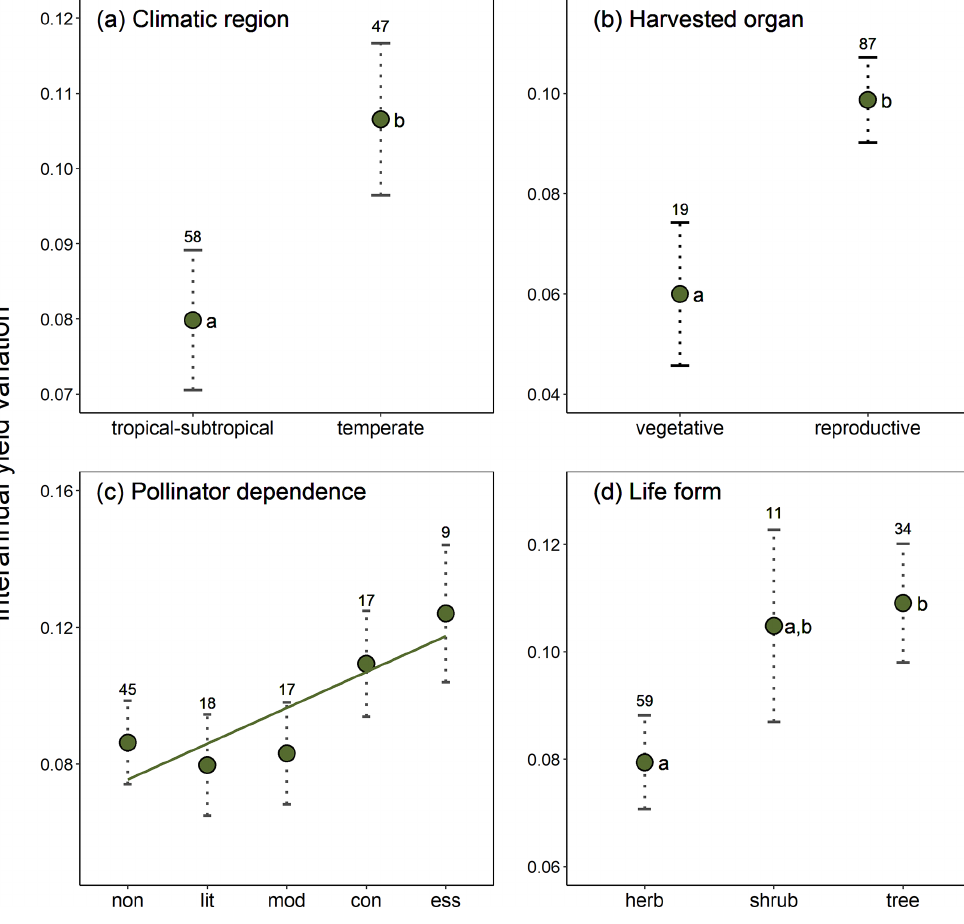
Figure 2. Effects of (a) climatic region, (b) type of harvested organ, (c) pollinator dependence, and (d) crop life form on interannual yield variation (SD( (cid:49) yield)). Model-adjusted estimated means are illustrated with points and standard errors with dotted lines. Sample sizes are shown for each category. The regression line in panel (c) illustrates the positive linear trend found for the relation between interannual yield variation and pollinator dependence (see Results). Significant differences among categories are indicated with different letters (Table A4). Pollinator dependence categories are abbreviated as “non” (none), “lit” (little), “mod” (moderate), “con” (considerable) and “ess” (essential). Note that SD ( (cid:49) yield) is unitless (see